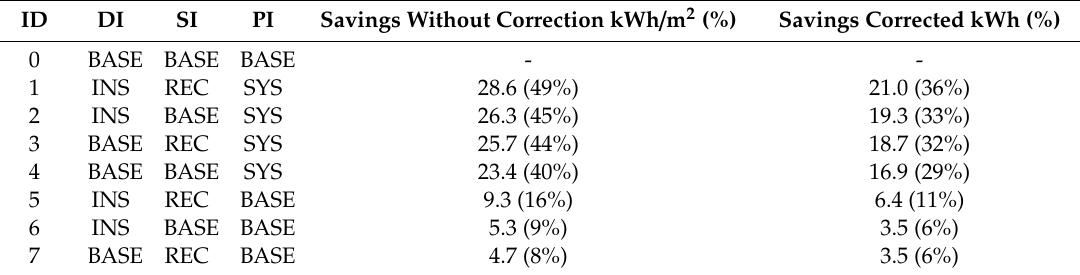
Table 5. Best energy savings measures for the case